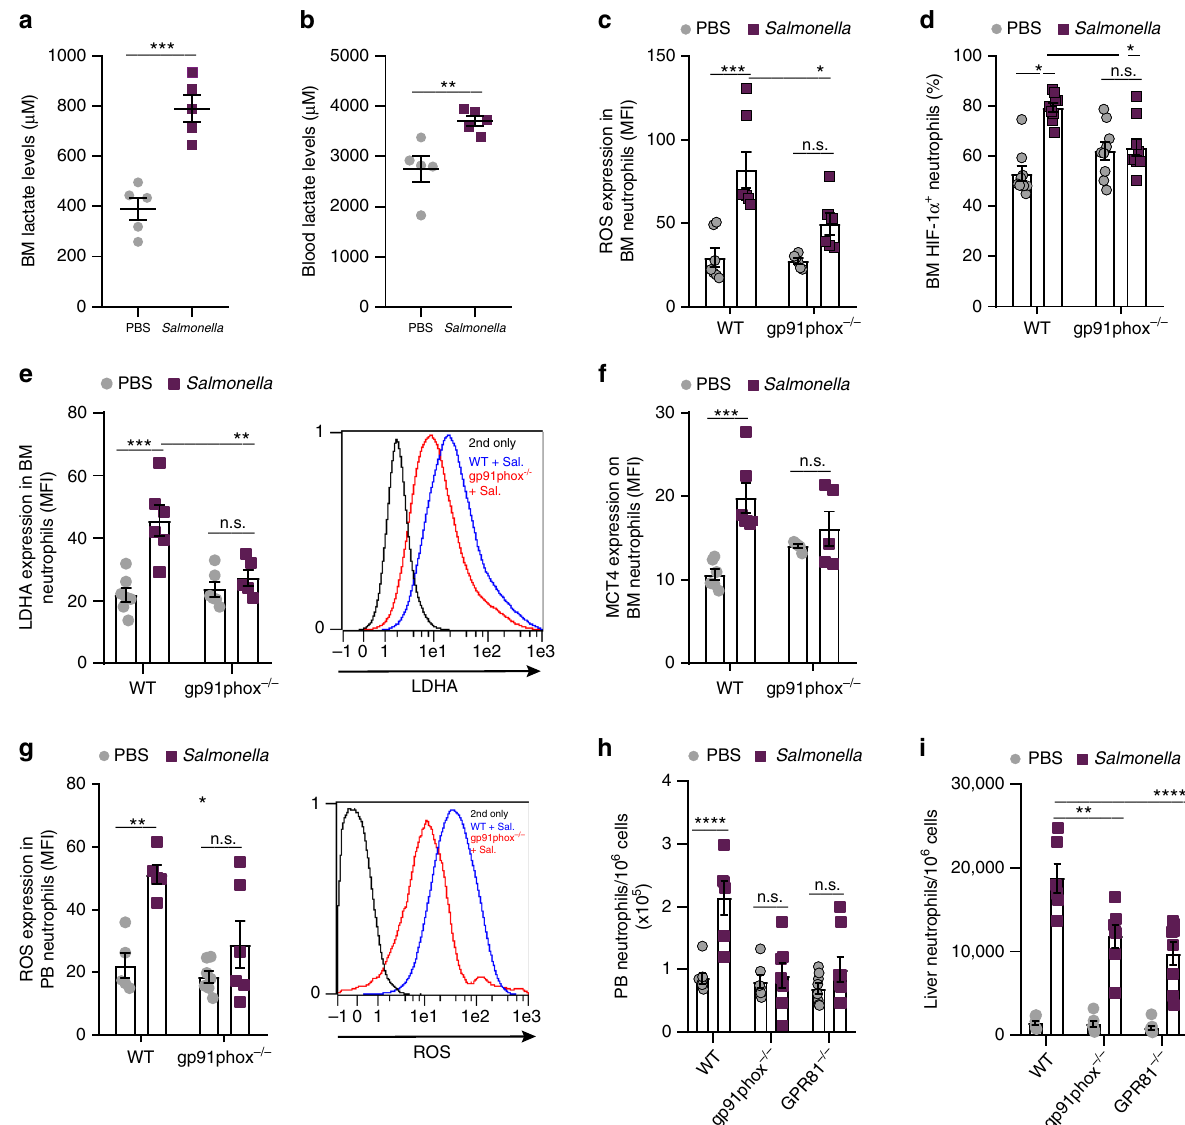
Fig. 7 Salmonella increases lactate production by in fl ammatory BM neutrophils. a , b Lactate levels in ( a ) BM or ( b ) blood from WT mice treated with PBS or Salmonella ( n = 5). a *** p (0.0004); b ** p (0.0081). c Quantitative analysis of ROS production in BM neutrophils from WT ( n = 7) vs. gp91phox − / − ( n = 6) mice infected with Salmonella . d Percentage of BM HIF-1 α + neutrophils in WT ( n = 9) vs. gp91phox − / − ( n = 9). e Quantitative analysis and representative fl ow cytometry histogram plot of LDHA expression in BM neutrophils from WT ( n = 7, PBS; n = 6, Salmonella; *** p (0.0001))